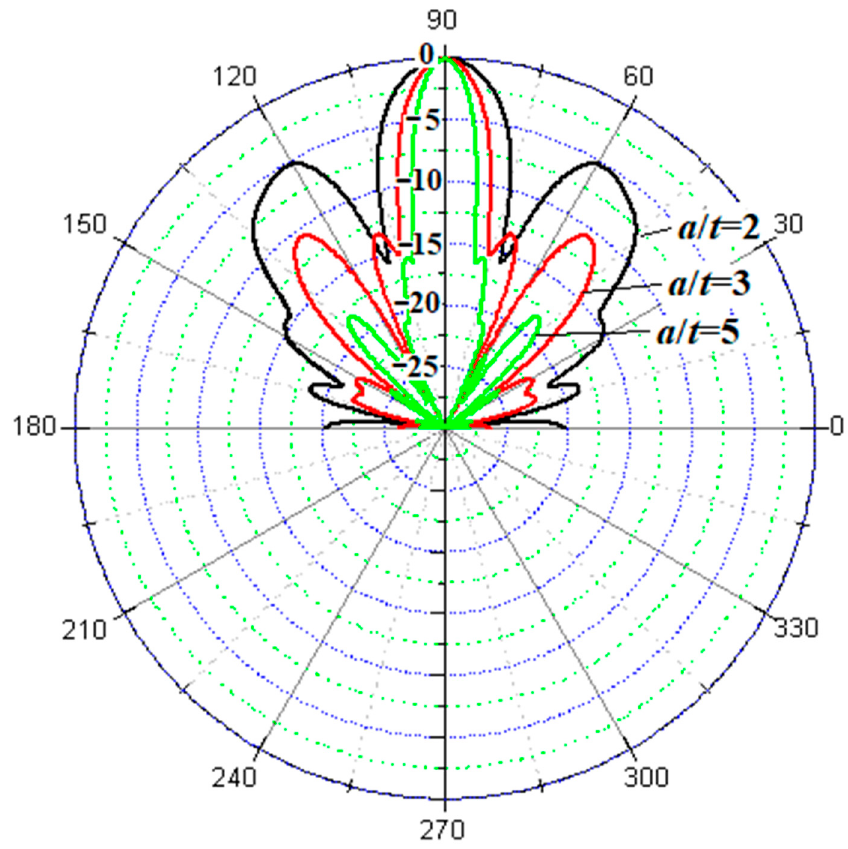
Figure 3. Influence of different a / t ratios on sidelobe level of the circular transducer.